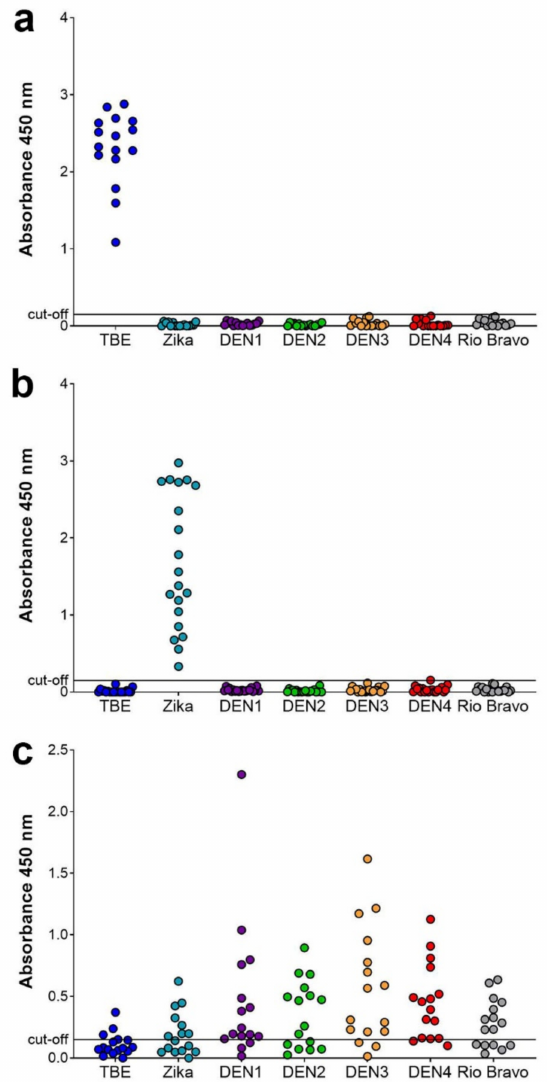
Figure 1. Flavivirus IgM E-complex ELISAs with the TBE, Zika and dengue serum samples. Sera from 16 TBE ( a ), 20 Zika ( b ) and 16 dengue patients ( c ) were analyzed in IgM E-complex ELISAs with soluble E proteins (sEs) of TBE, Zika, dengue (DEN)1, DEN2, DEN3, DEN4, and Rio Bravo viruses. Serum samples from two patients sent to our institution for dengue/Zika diagnosis yielded a pattern suggestive of a double infection with dengue and Zika viruses.